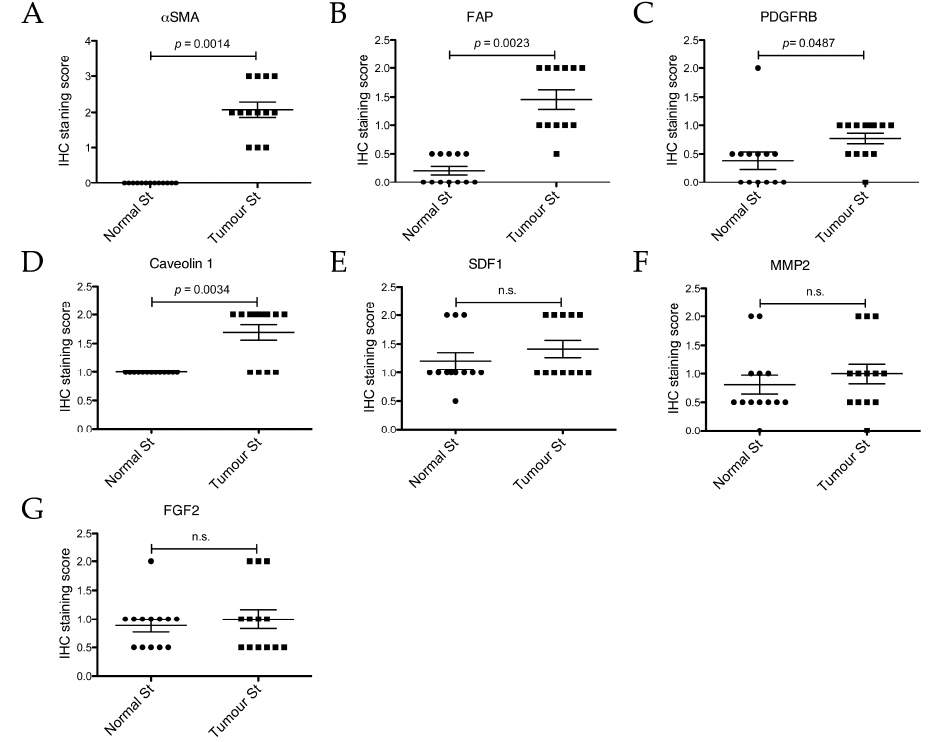
Figure 5. Immunohistochemical staining scores of the normal and tumour stroma (normal st and tumour st, respectively) from the 13 different cases for different proteins. Slides were stained with the indicated antibodies and scored. ( A ): α SMA; ( B ): FAP; ( C ): PDGFR β ; ( D ): Caveolin 1; ( E ): SDF1; ( F ): MMP2; ( G ): FGF2. IHC for FAP could only be performed on 12 cases due to the unavailability of case #7 at the time of processing. Plotted are all individual values and the mean ± SEM of the IHC staining scores. p -values are two-tailed and were calculated using the Wilcoxon signed rank test, with significance set at p ≤ 0.05. n.s. = not